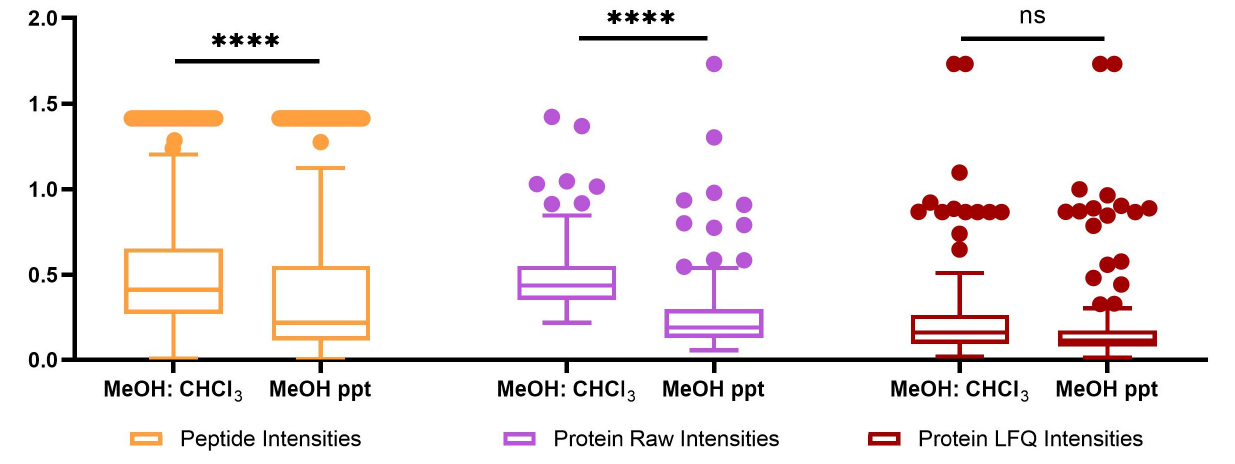
Figure 3. Analysis of variation for proteomics data: distribution of CV values for peptide, raw protein and LFQ protein intensities, compared between the two extraction methods. **** indicates p ≤ 0.0001, ns indicates not significant. Table 2. Comparing numbers of identified proteins and their average variation. MeOH: CHCl 3